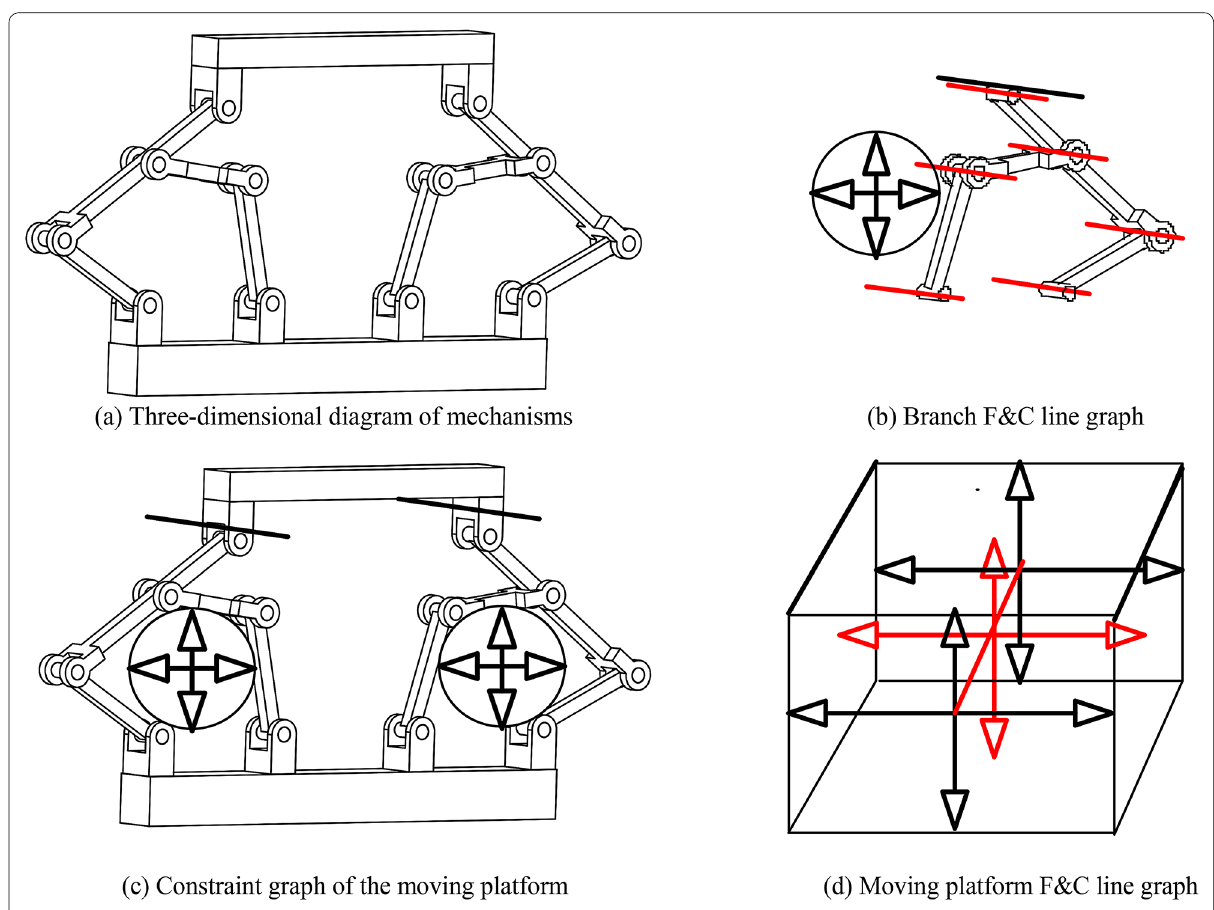
Figure 19 Correlated line diagram at initial